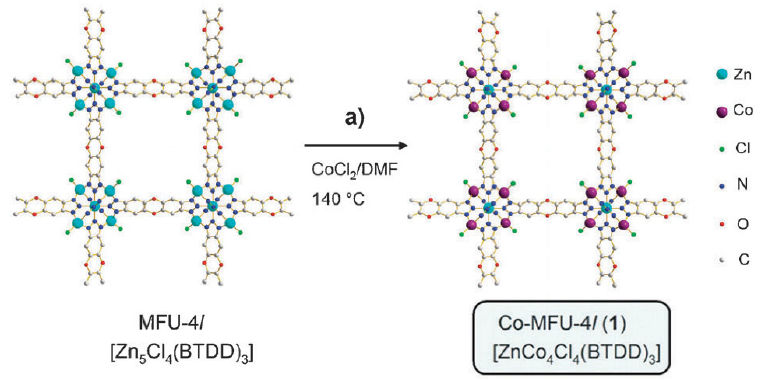
Figure 6. Structure and post-synthetic cobaltation of MFU-4. Turquoise = Zn, Maroon = Co, Green = Cl, Blue = N, Red = O, Gray = C. Adapted with permission from [78]; Published by Royal Society of Chemistry, 2012.